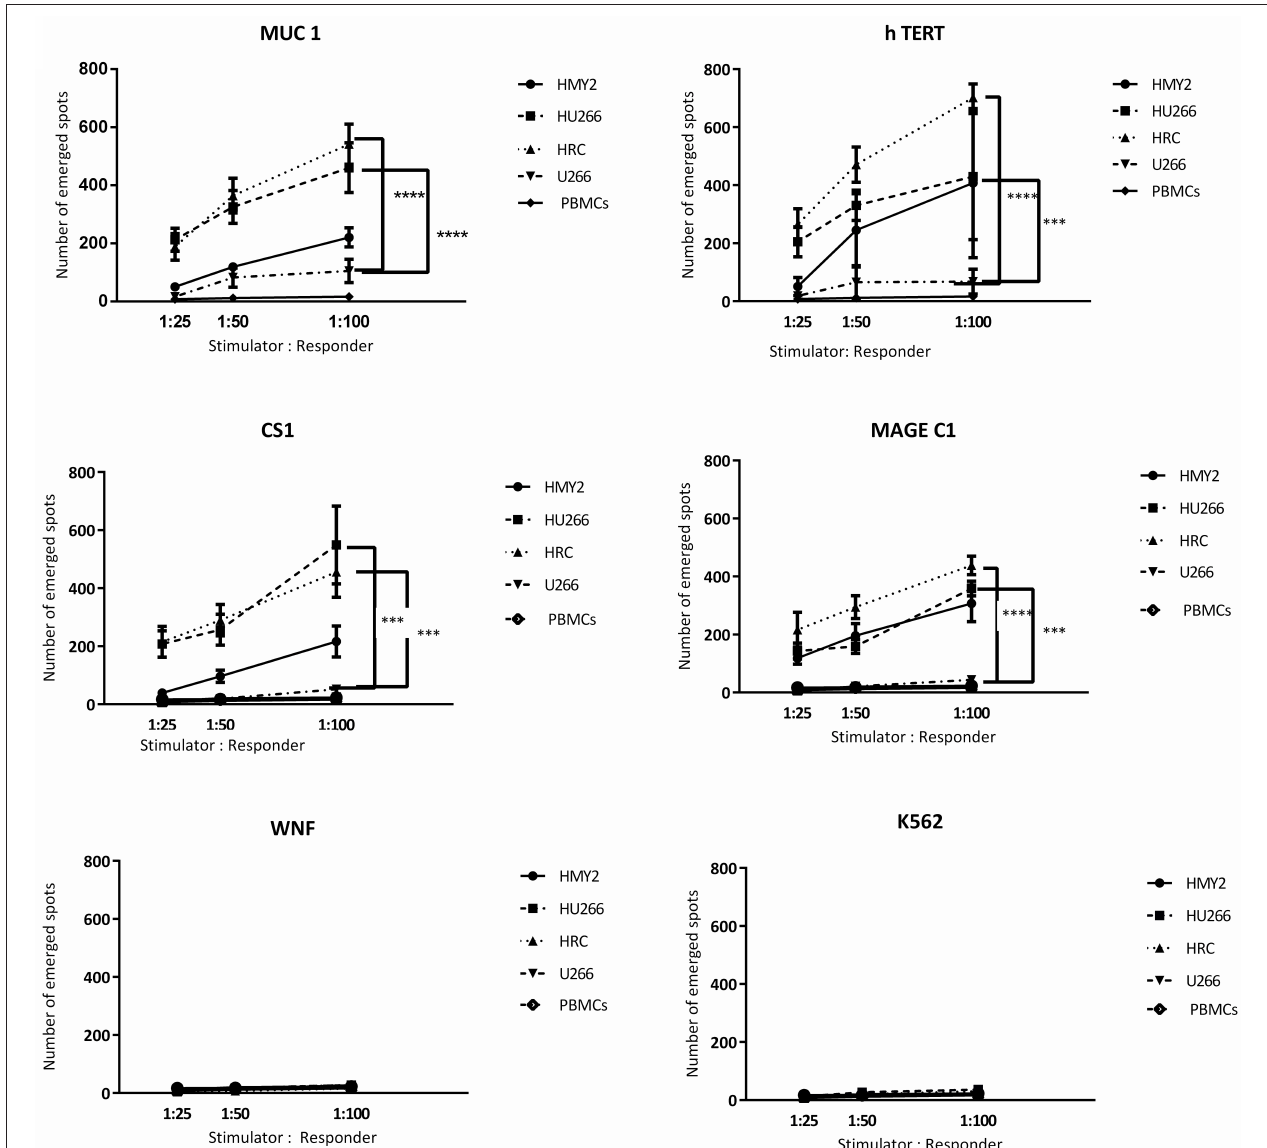
FIGURE 4 | IFN- γ release ELISpot assays. Allogeneic PBMCs, isolated from five different HLA-A2 + MM patients were stimulated with HMY2, HU266, HRC, or U266. The resulting responder cells were mixed with T2 stimulator cells (after pulsing with MUC1, hTERT, CS1, MAGE-C1, and WNF derived peptides) in IFN- γ ELISpot assays. K562 were used as controls to assess NK activity. The number of emerged spots (Y axis) is presented as mean value of the patients’ responses ± SEM. The stimulator: responder ratios are presented on the X axis. PBMCS stimulated with the used cell lines without further stimulation in the ELISPOT assay were used as negative controls. Levels of significance difference between the level of IFN- γ release of antigen specific T cells induced by the hybrid cell lines (HRC and HU266) and the parent myeloma cell line U266 are indicated as asterisks (*** p ≤ 0.001 and **** p ≤ 0.0001).